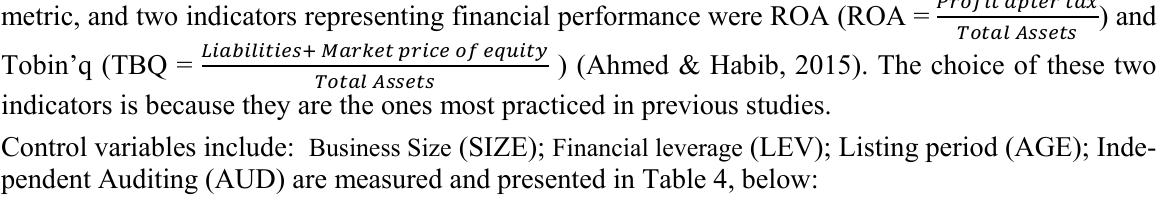
Measurement of Control Variables Code Control Variable Measurement SIZE Firm size Log (Total Assets) LEV Financial leverage Total long-term debt divided by total assets AGE Listing period Number of years from the beginning of listing to the end of 2017 AUD Independent